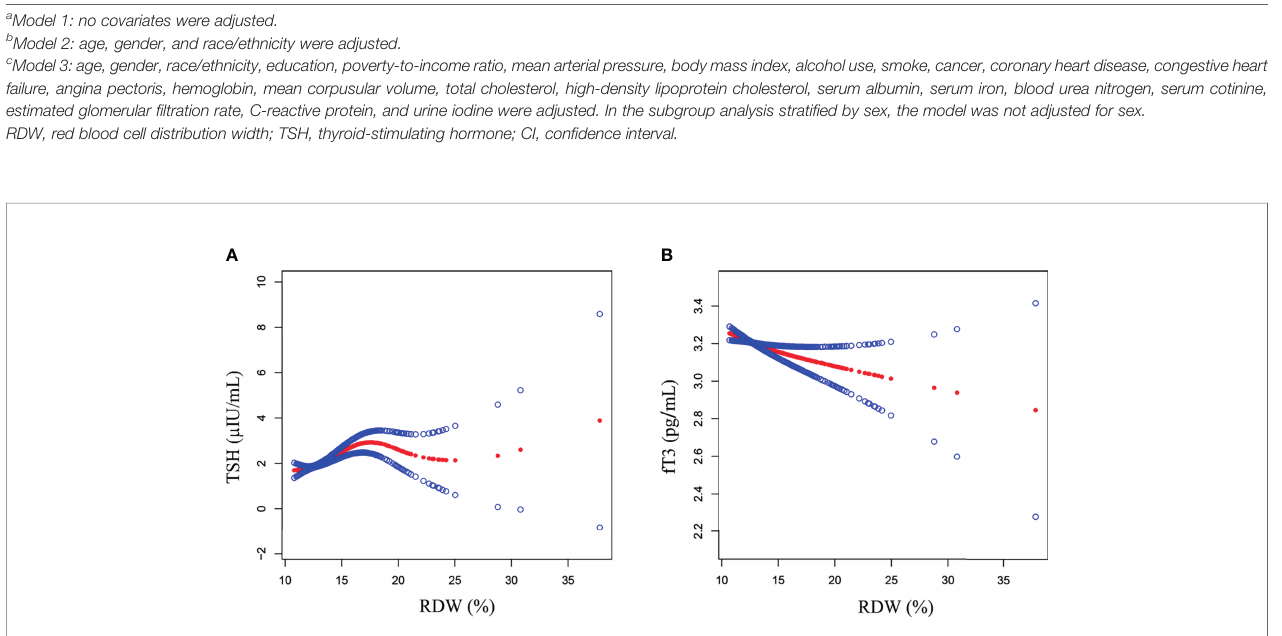
FIGURE 2 | The association between RDW and TSH, as well as fT3. Solid red line represents the smooth curve fi t between RDW and TSH (A) , as well as fT3 (B) . Blue bands represent the 95% of con fi dence interval from the fi t. Age, gender, race/ethnicity, education, poverty-to-income ratio, mean arterial pressure, body mass index, alcohol use, smoke, hemoglobin, mean corpusular volume, total cholesterol, high-density lipoprotein cholesterol, serum albumin, serum iron, blood urea nitrogen, serum cotinine, estimated glomerular fi ltration rate, C-reactive protein, and urine iodine were adjusted. TSH, thyroid-stimulating hormone; fT3, free triiodothyronine; RDW, red blood cell distribution width.